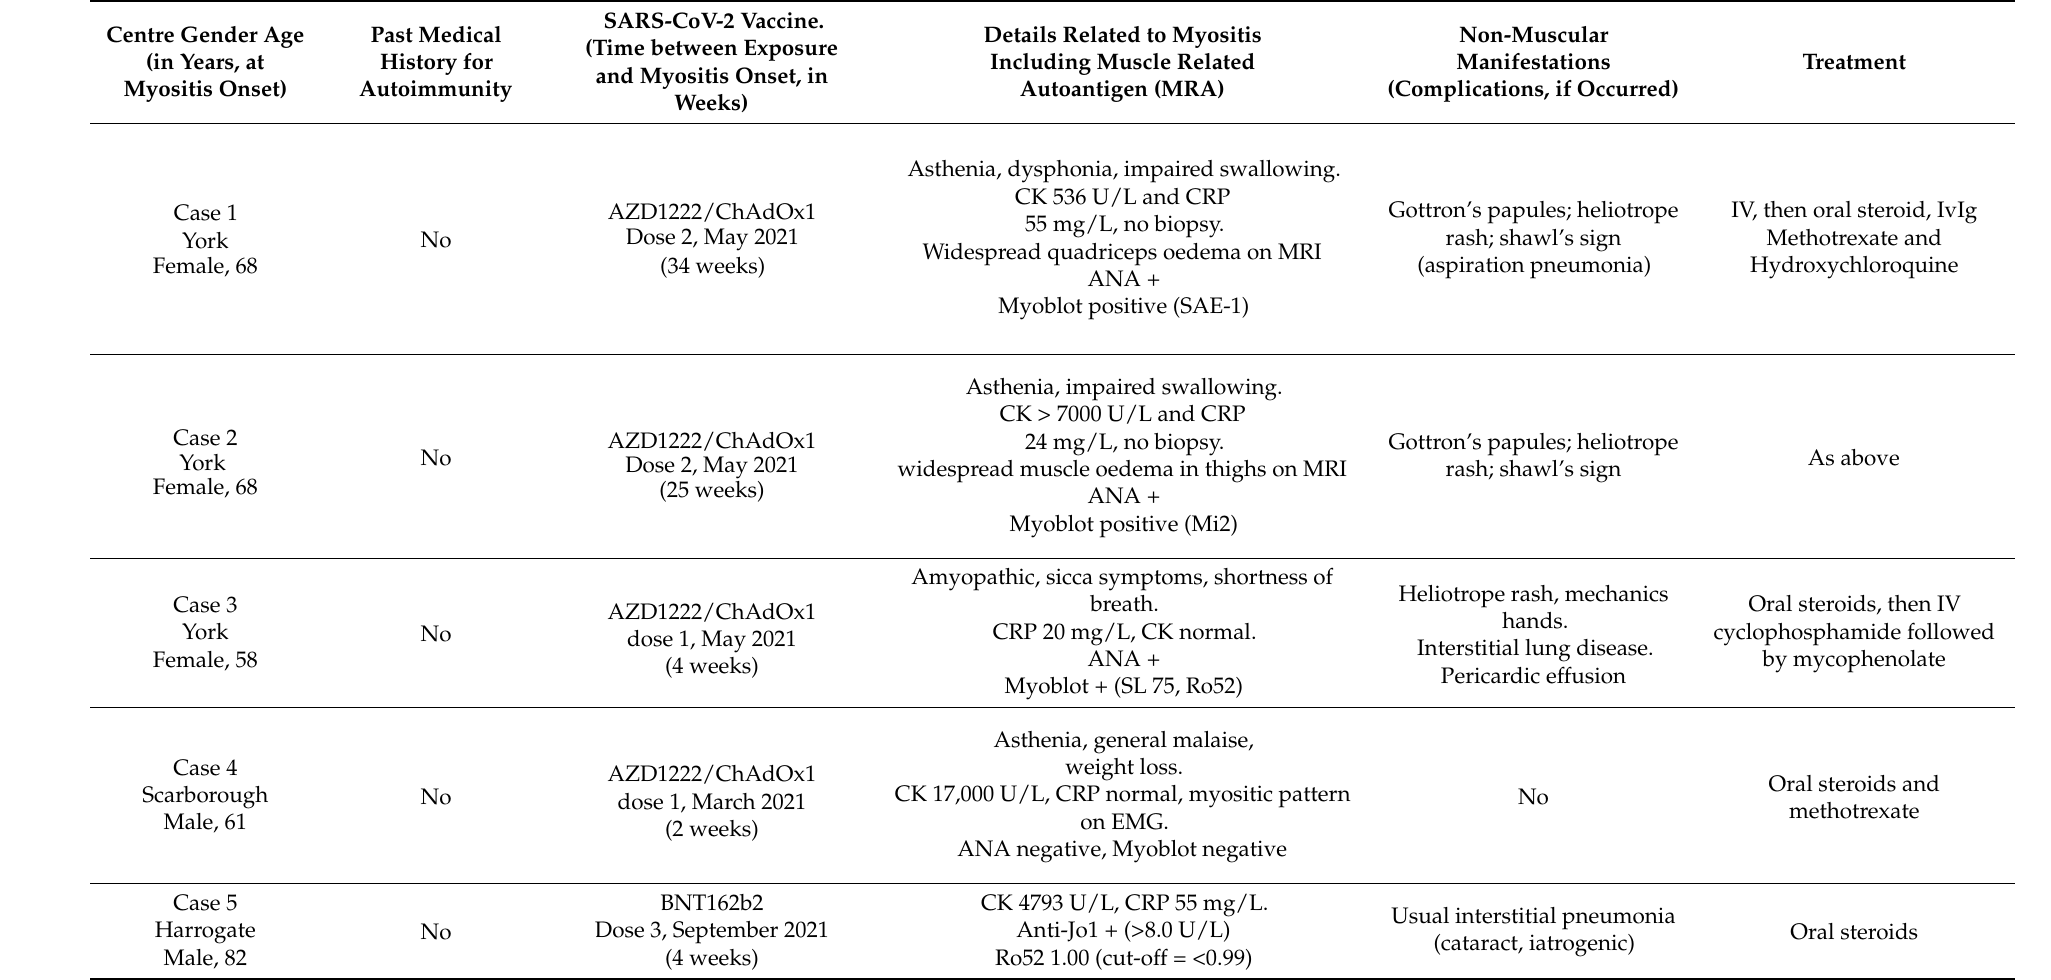
Table 1. Clinical, laboratory and Imaging Features of Myositis